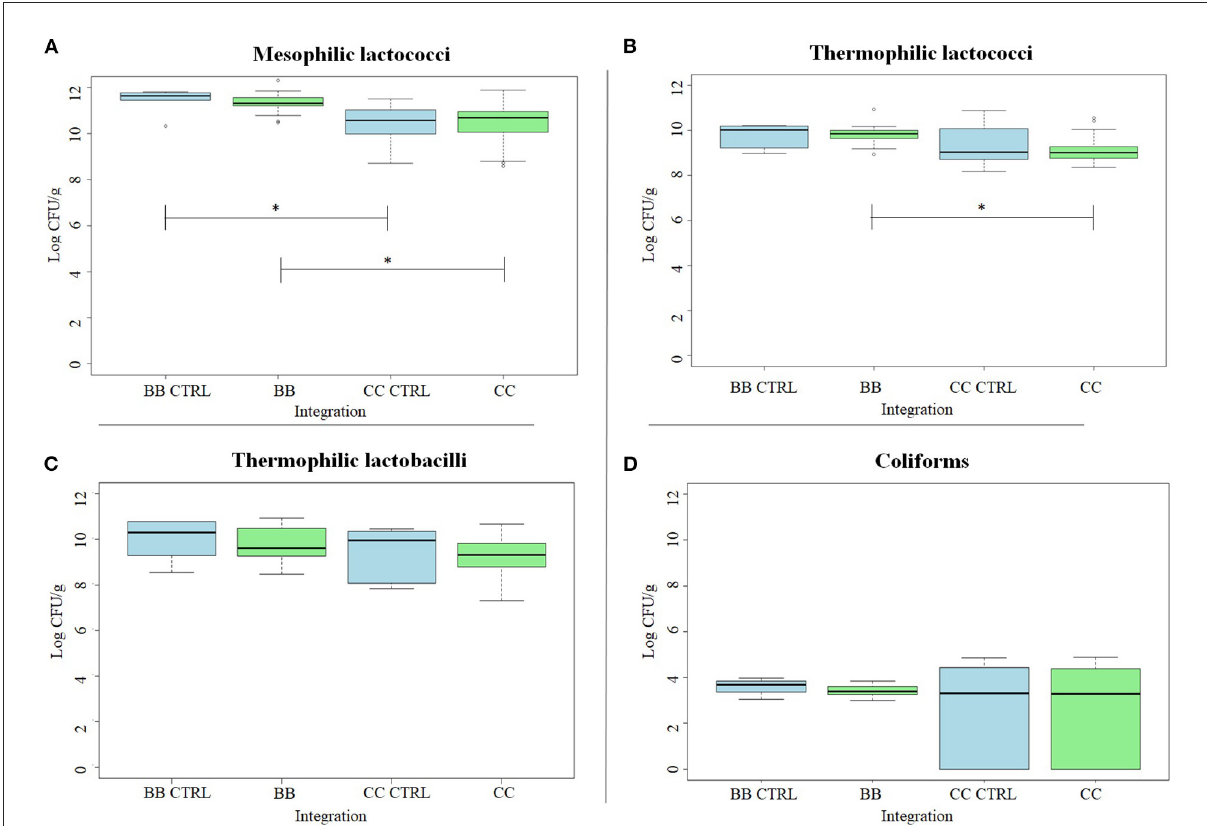
FIGURE2 Box plots of observed mesophilic cocci (A) , thermophilic cocci (B) , thermophilic lactobacilli (C) , and coliforms (D) . Counts (Log CFU/g) in cheeses enriched with Ribes nigrum (BB) and Cornus mas (CC) and in respective CTRL (BB-CTRL and CC-CTRL) after 4 weeks of ripening. CTRL is colored in blue; enriched cheeses are colored in green. The thick horizontal black bars indicate the medians; the boxes indicate the range between the first (25th percentile) and the third quartile (75th percentile). The whiskers represent extreme values. Significant differences among CTRL and enriched cheeses are indicated by an asterisk (*: p <